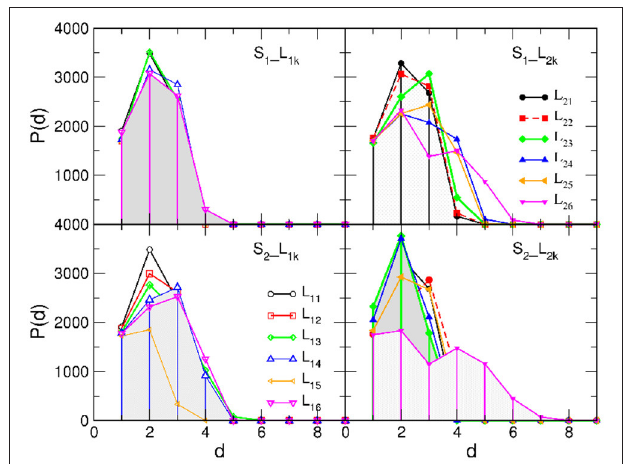
FIGURE 4 | Histograms of the shortest-path distances between nodes in brain-to-brain coordination networks of different listeners (indicated in the legend) with the speaker S 1 (Top) and S 2 (Bottom) panels.